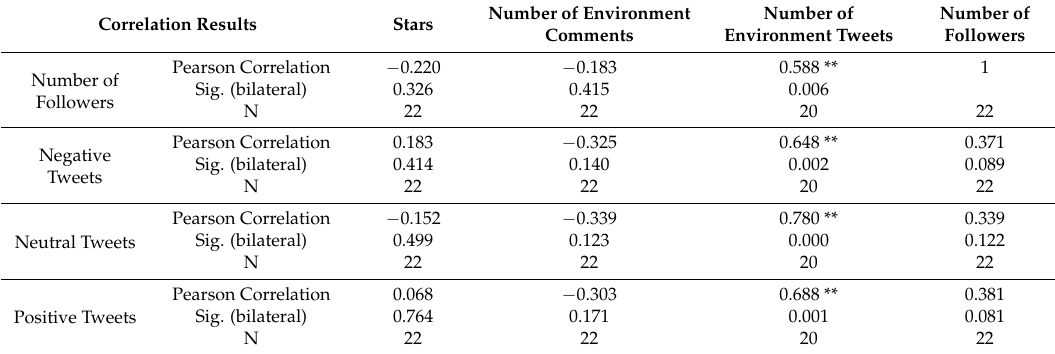
Table 15. Bivariate linear correlation results for environmental